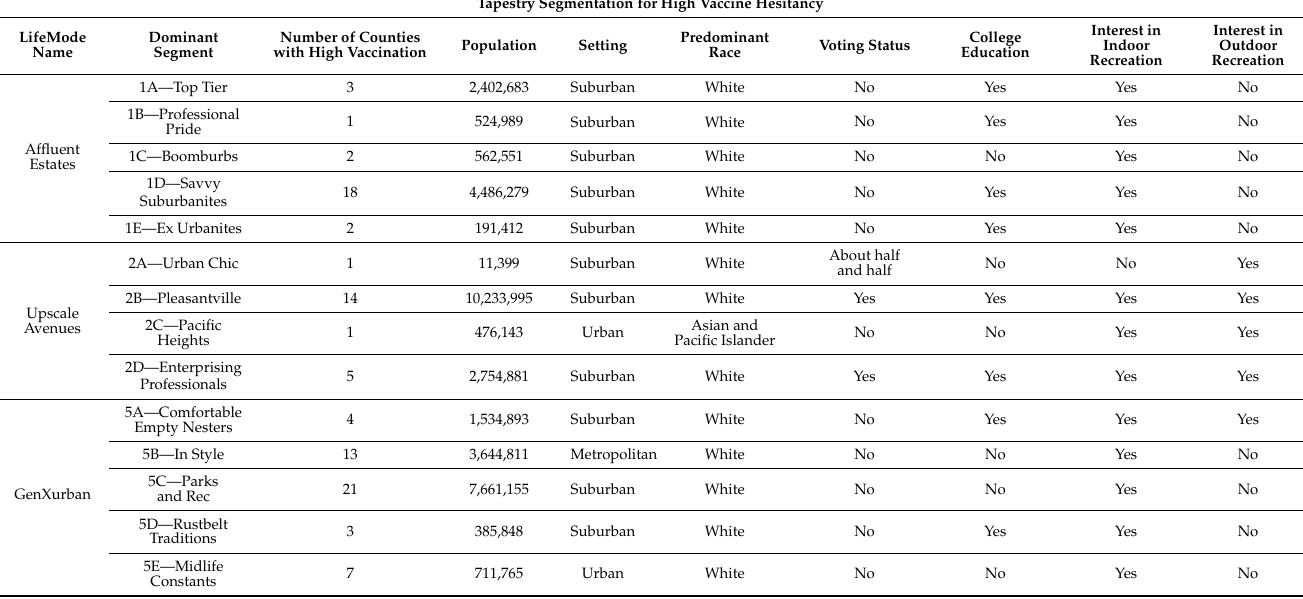
Table A2. Summary of High, Neutral and Low Vaccine Uptake LifeModes, along with their predominant lifestyle